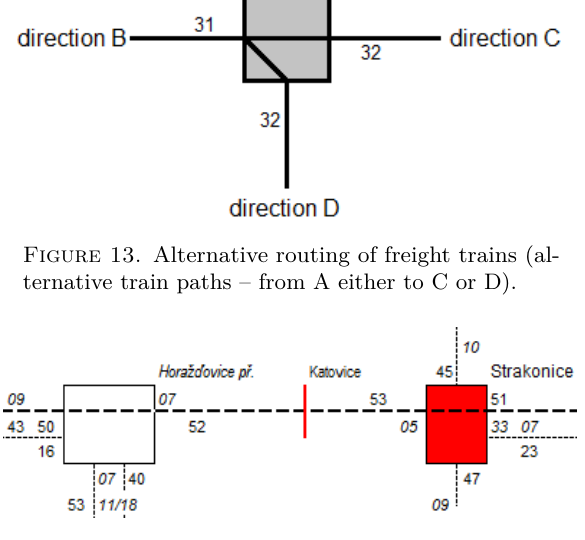
Figure 14. Example of descriptor of a crossing station (zero symmetry)